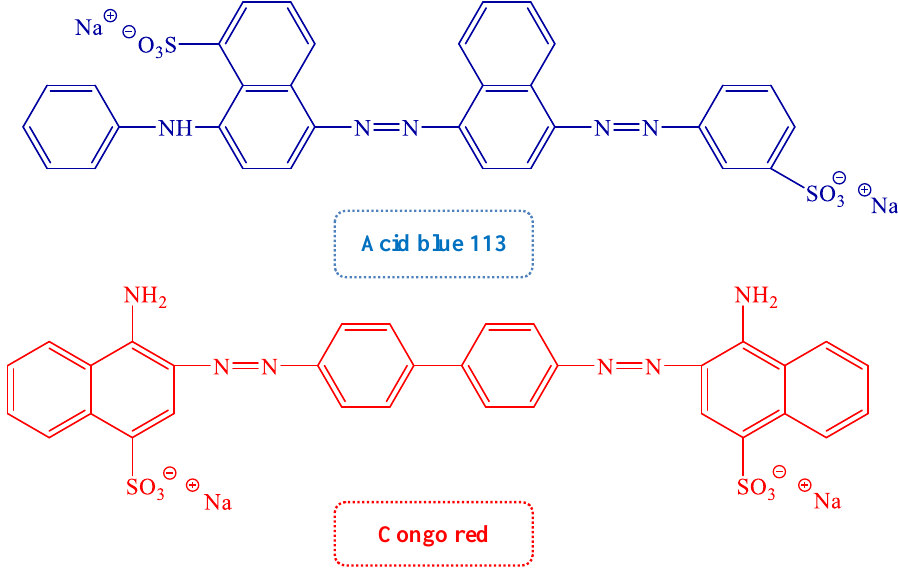
Figure 8. Molecular Structures of AB 113 and CR dyes.